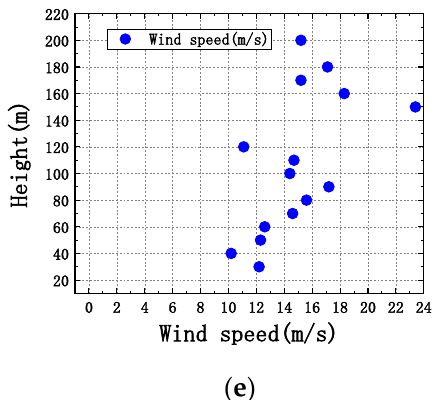
Figure 5. Form of wind profile: ( a ) messy type; ( b ) exponential type; ( c ) regular distribution type; ( d ) reverse type; ( e ) large zigzag type; ( f ) small zigzag type.